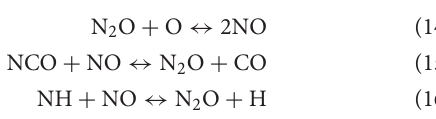
Frontiers in Mechanical Engineering |